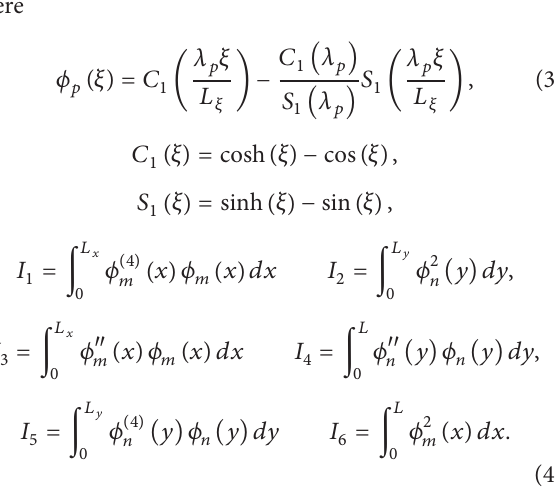
values, a nearly uniform field can be